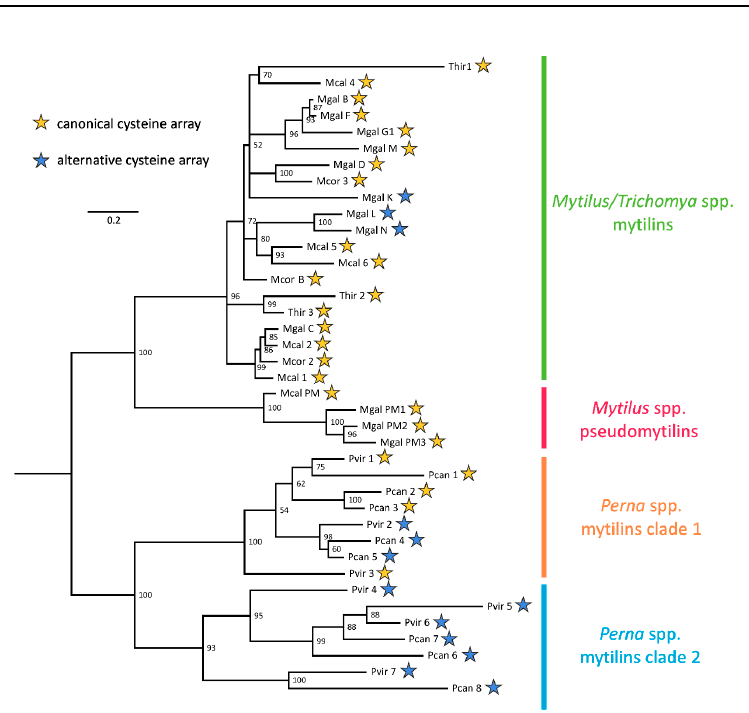
Figure 5. Bayesian tree built from all mytilin-like sequences, based on a JTT + I + G model of molecular evolution (see Section 3.4). Nodes below 50% support were collapsed. PM: pseudomytilin; Mcal: M.